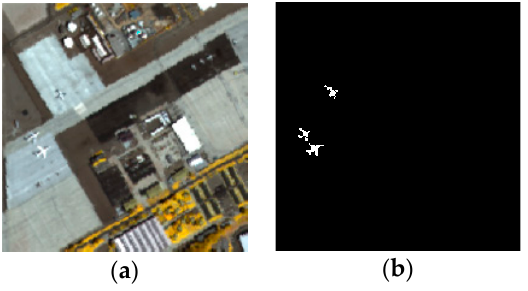
Figure 3. ( a ) The false color sense of San Diego airport data (bands 53, 33, 19). ( b ) The ground truth of the targets.